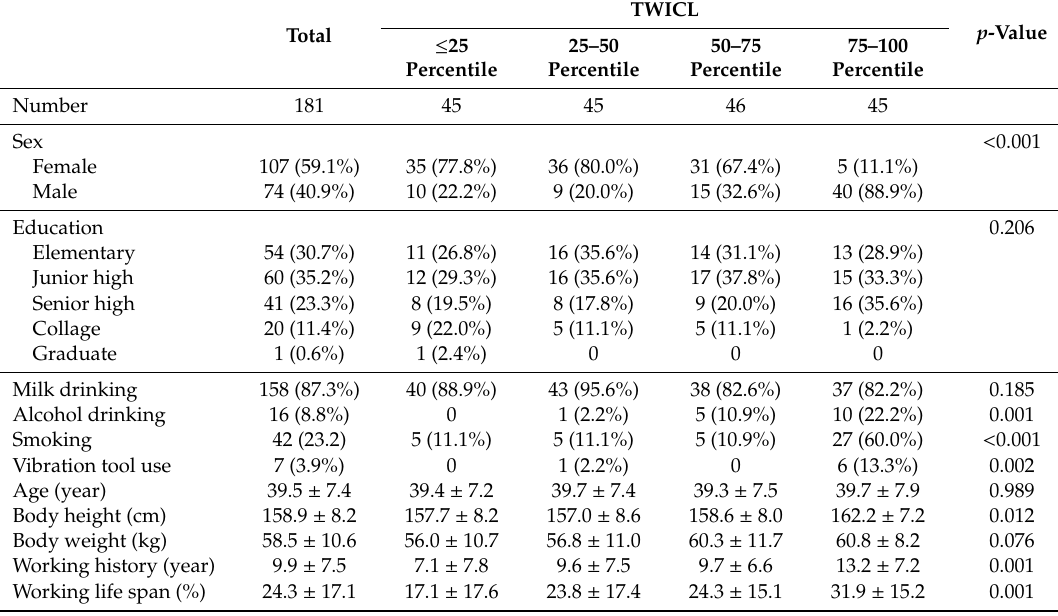
Table 1. Characteristics of the lead workers participating in the study.